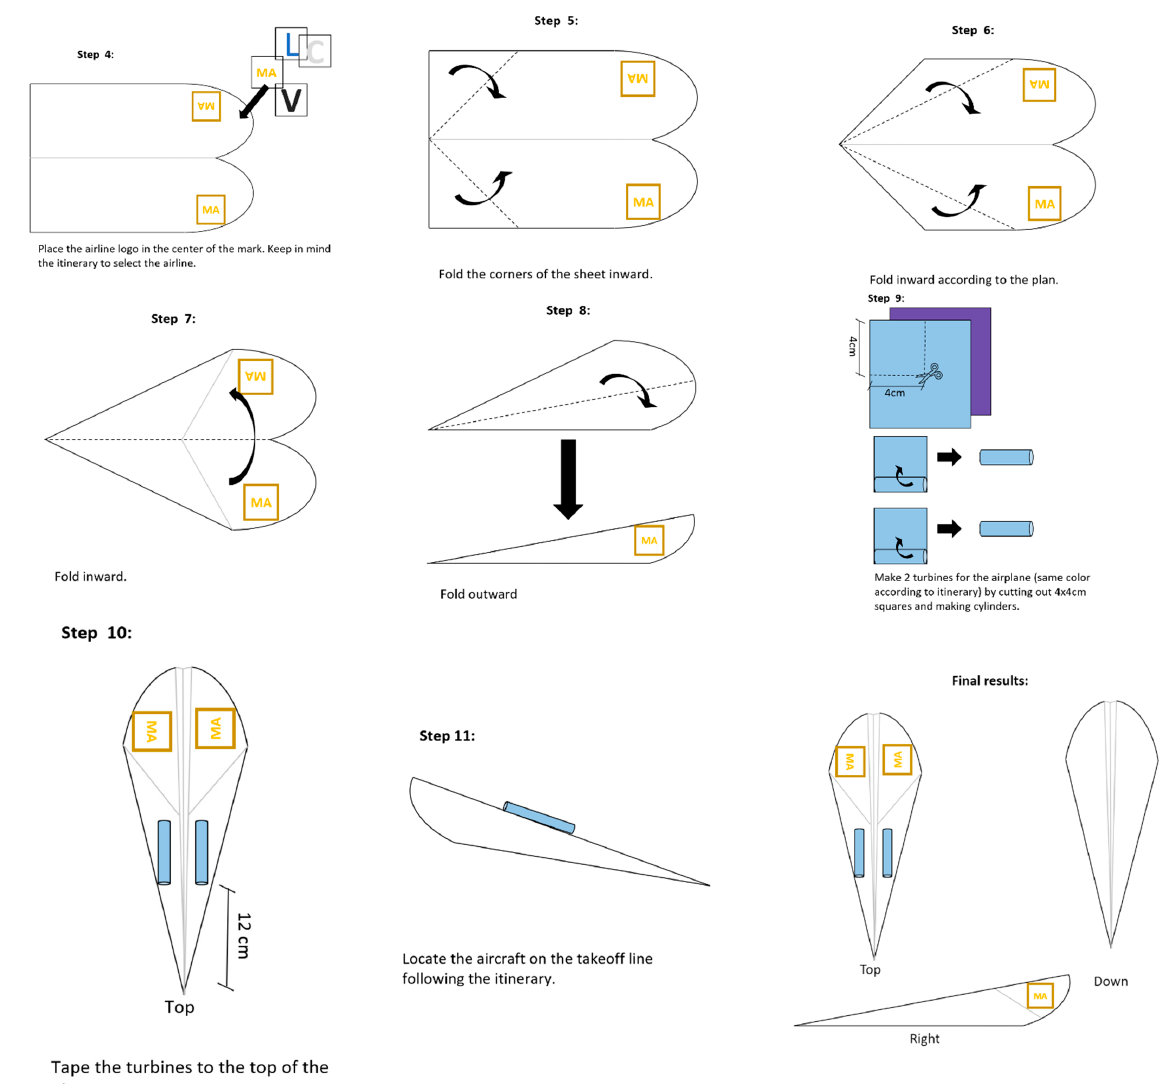
Figure A1. Paper plane drawings.